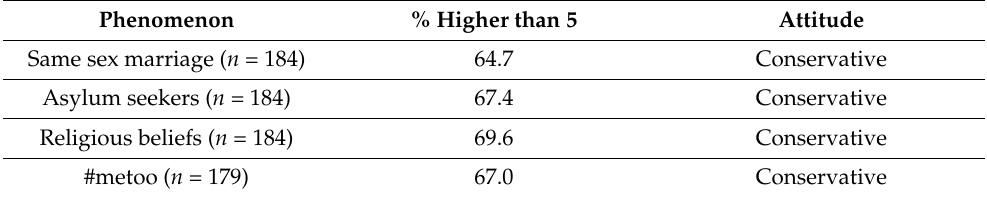
Table 8. Younger men: Selected socio-political issues; (0 = Progressive; 10 = Conservative). Phenomenon % Higher than 5 Attitude Same sex marriage ( n = 184) 64.7 Conservative Asylum seekers ( n = 184) 67.4 Conservative Religious beliefs ( n = 184) 69.6 Conservative #metoo ( n = 179) 67.0